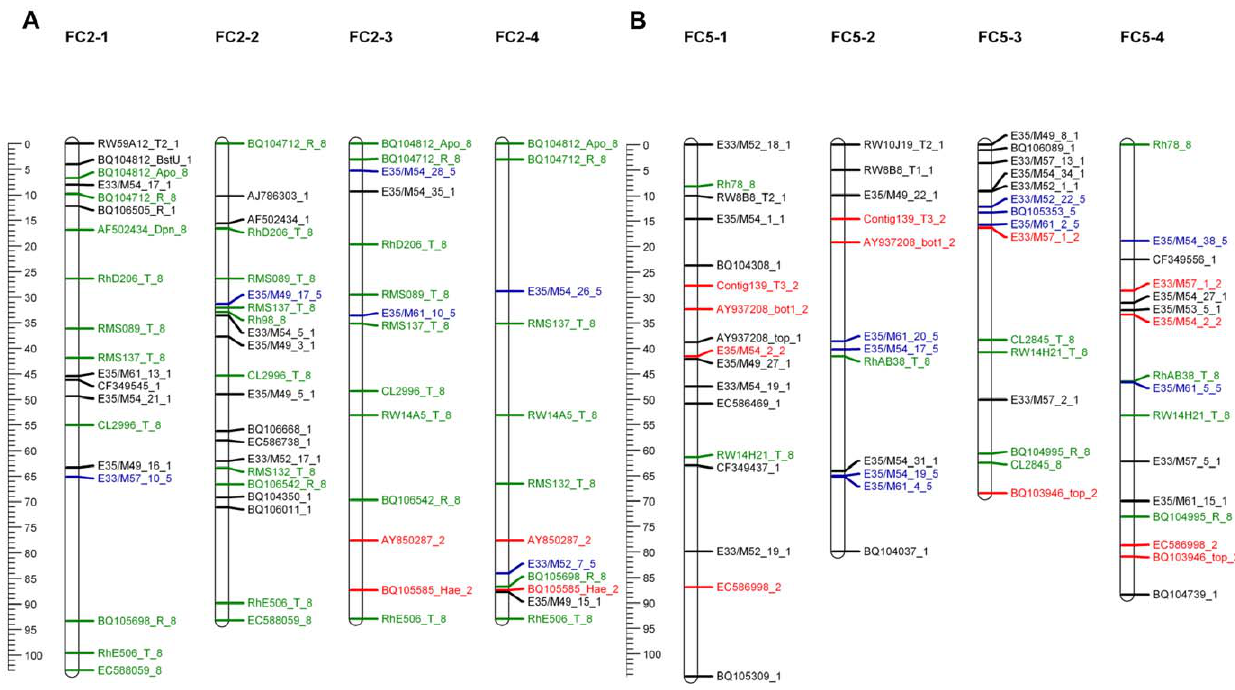
Figure 7. Two of the Fragrant Cloud (FC) linkage groups showing the four homologous chromosomes (1 – 4) . Map distances are shown in cM as a ruler at the left page margin. Marker names indicated according to the nomenclature described in Table S1 . Each color represents a different segregation ratio (black for 1:1, red for 5:1, blue for 3:1 and green for codominant markers). A . Linkage group 2. B . Linkage group 5.